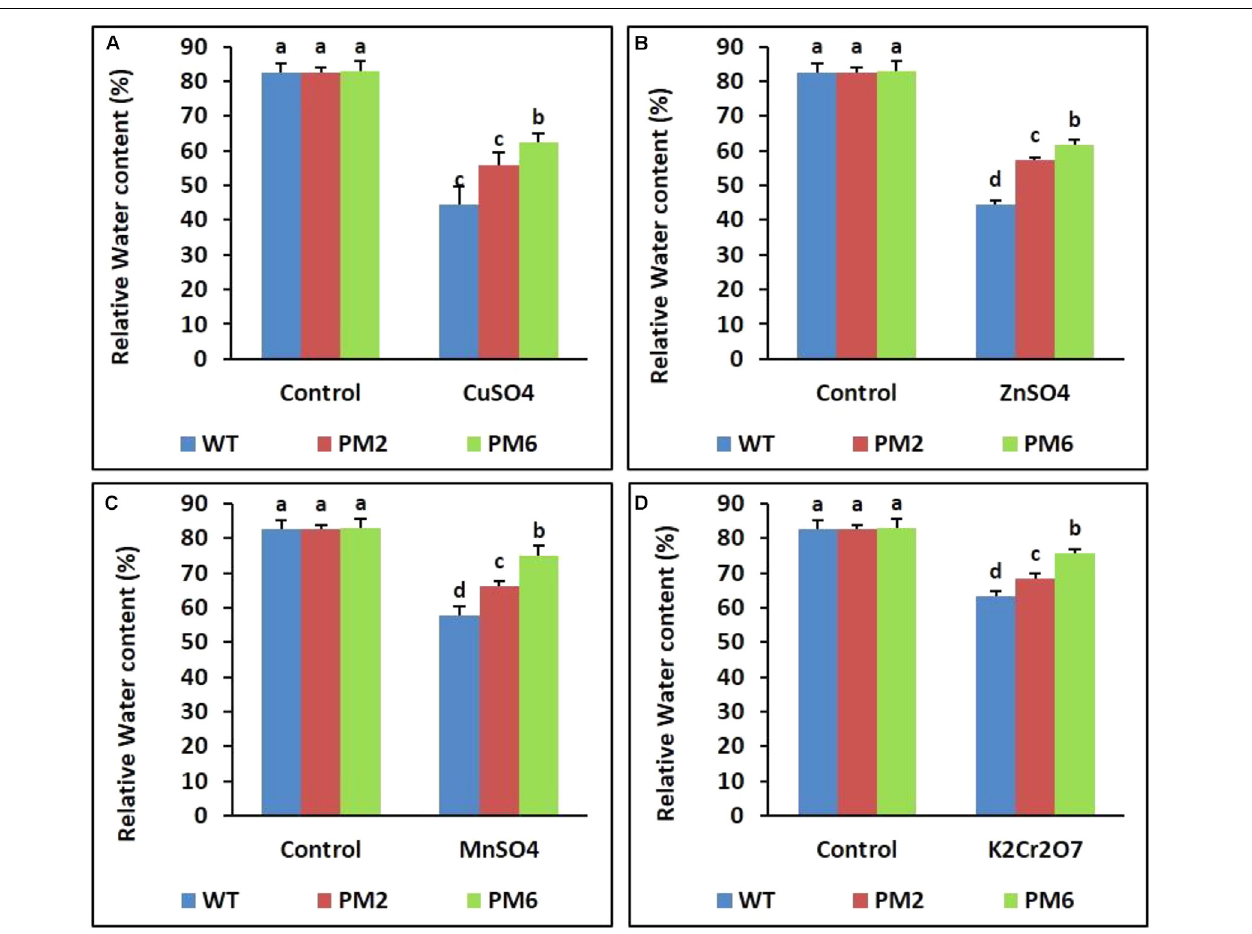
FIGURE 5 | Comparison of relative water content (RWC) in the T 2 -PM6, T 2 -PM2, and WT plants after exposure to the indicated heavy metals ( A , CuSO 4 ; B , ZnSO 4 ; C , MnSO 4 ; D , K 2 Cr 2 O 7 ). Data were acquired on the thirtieth day after starting the experiments. Error bars show the